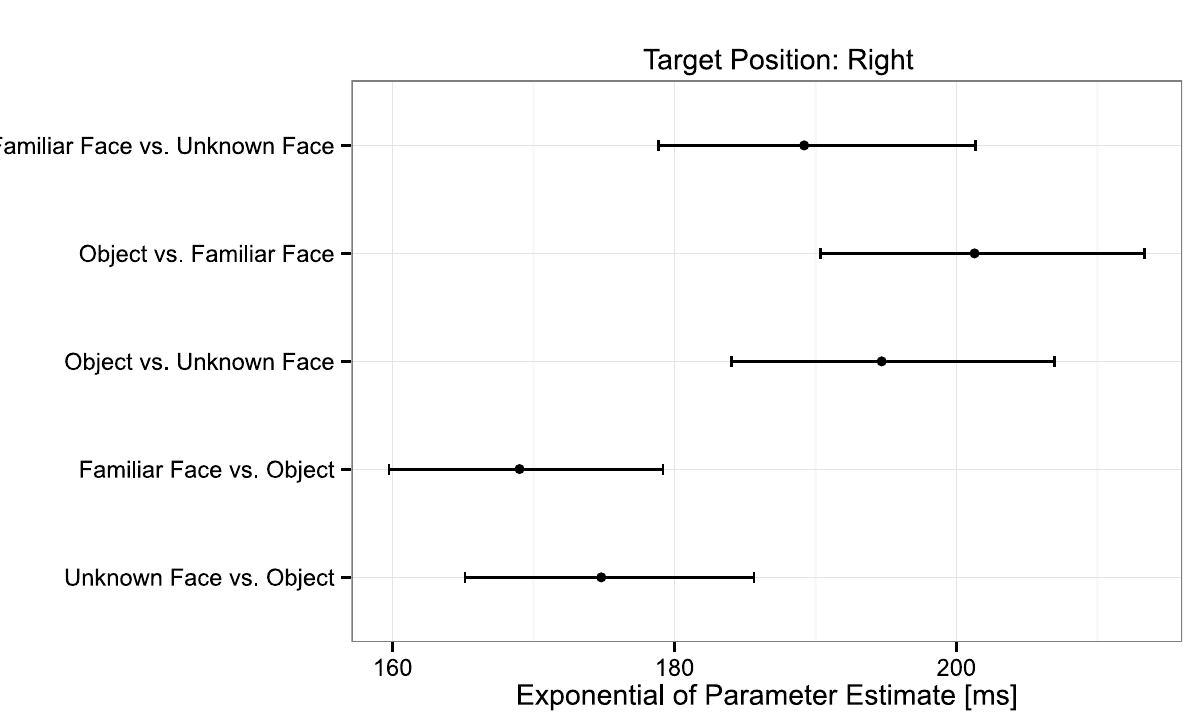
Fig 4. Parameter estimates for Task in the Linear Mixed-Effects Models obtained by changing reference level for target position. Error bars represent 95% bootstrapped confidence intervals.